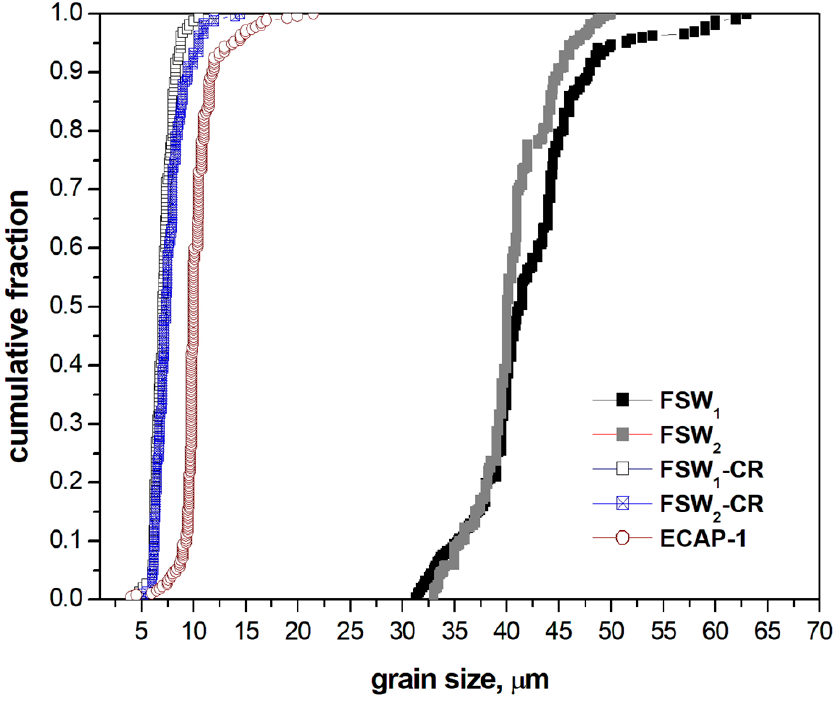
Figure 6. Grain size distribution of FSW 1 , FSW 2 , FSW 1 -CR, FSW 2 -CR, and ECAP-1.